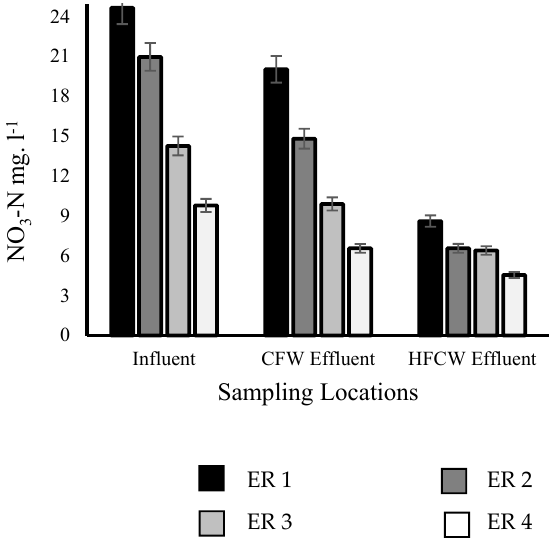
Figure 3. NO 3 –N concentration during different experimental runs in the first setup.